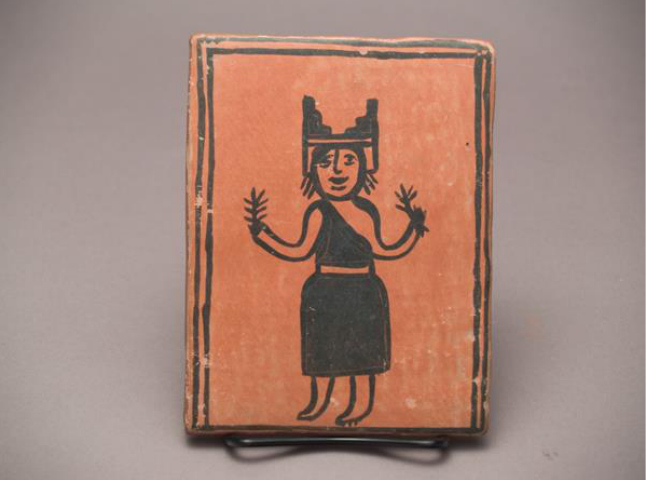
Figure 9. Crescencio Martinez, Tile, c. 1917–1918. Courtesy of the Museum of Indian Arts and Culture, Laboratory of Anthropology, Santa Fe, NM, 18755/12.